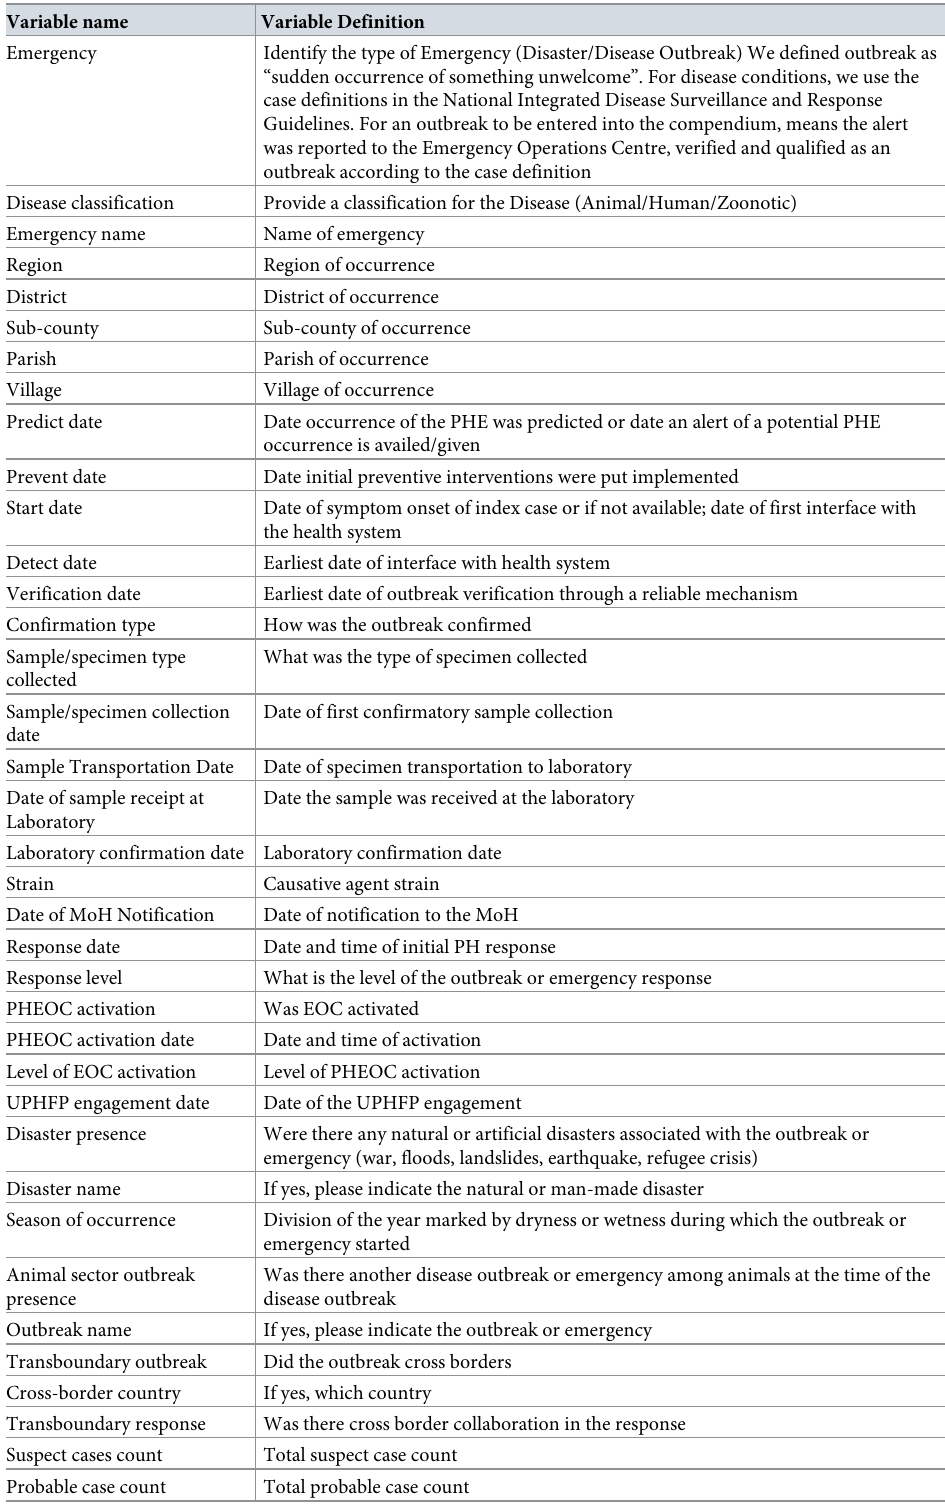
Table 1. Data dictionary of variables included in the